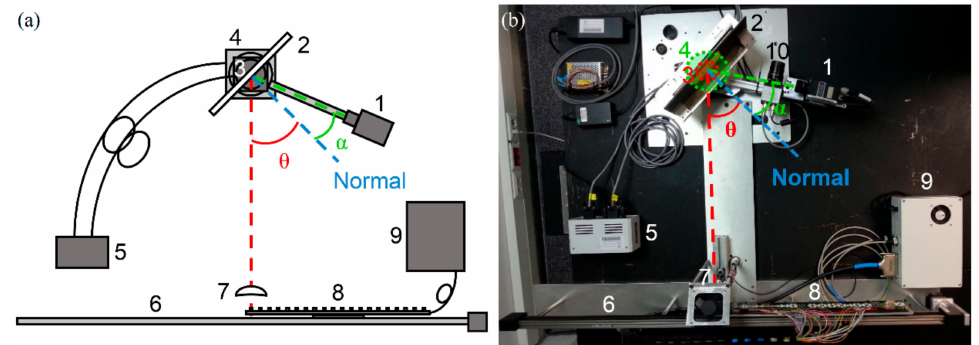
Figure 2. Developed gonio-hyperspectral imaging system based on LEDs represented in ( a ) a layout and in ( b ) a picture: 1. UV–VIS camera, 2. sample holder, 3. 8MR191-30 rotation stage, 4. 8MR191-30-28 rotation stage, 5. rotation stages controller, 6. linear actuator, 7. lens, 8. LED clusters, 9. light